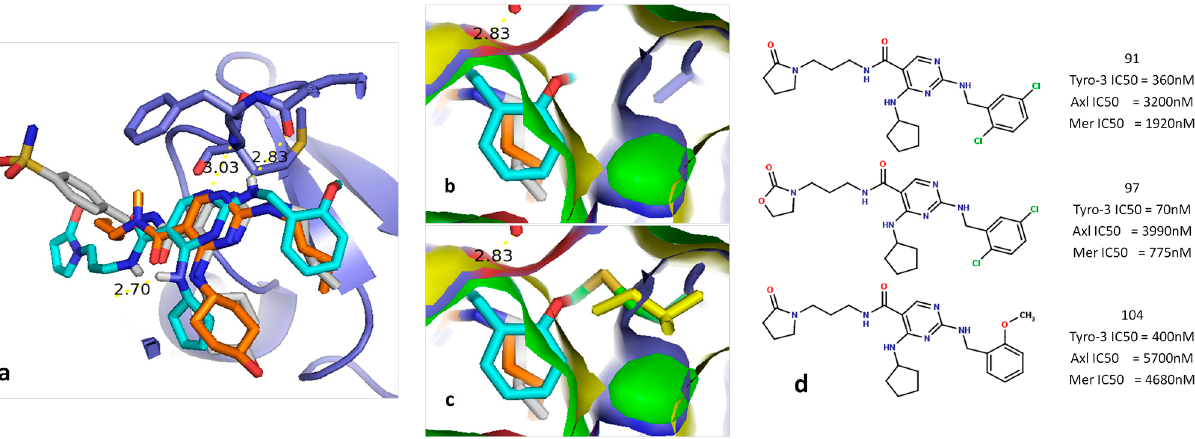
Figure 6. Comparison and overlapping of compound 104 docked in the Tyro-3 model aligned with the PDB ligands UNC1817 (PDB: 4MHA) and UNC1896 (PDB: 4MH7). ( a ) Overview of the overlapping of the three ligands in the active site of the Tyro-3 model. ( b ) Overview of the distance between the methoxyphenyl fragment in compound 104 and the Ala581 side chain of Tyro-3. ( c ) Overview of the distance between the methoxyphenyl fragment in compound 104 and either Met598 in Axl or the Ile650 side-chain in Mer. ( d ) Representation of the three diaminopyrimidine-based inhibitors selective for